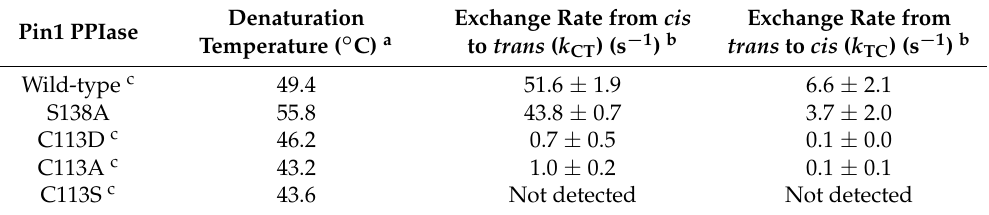
Table 1. Global structural stabilities and the cis - trans isomerization rates for a series of Pin1 peptidyl-prolyl isomerase (PPIase)